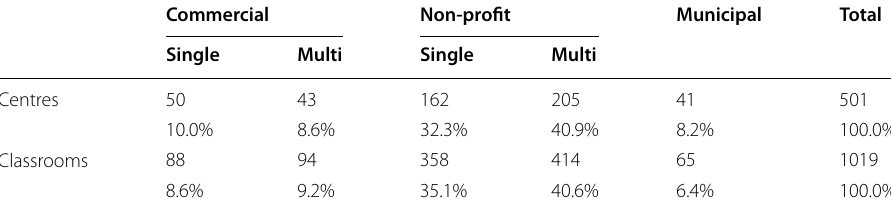
Table 1 Study frame—child care centres and number of rooms by operator type Commercial